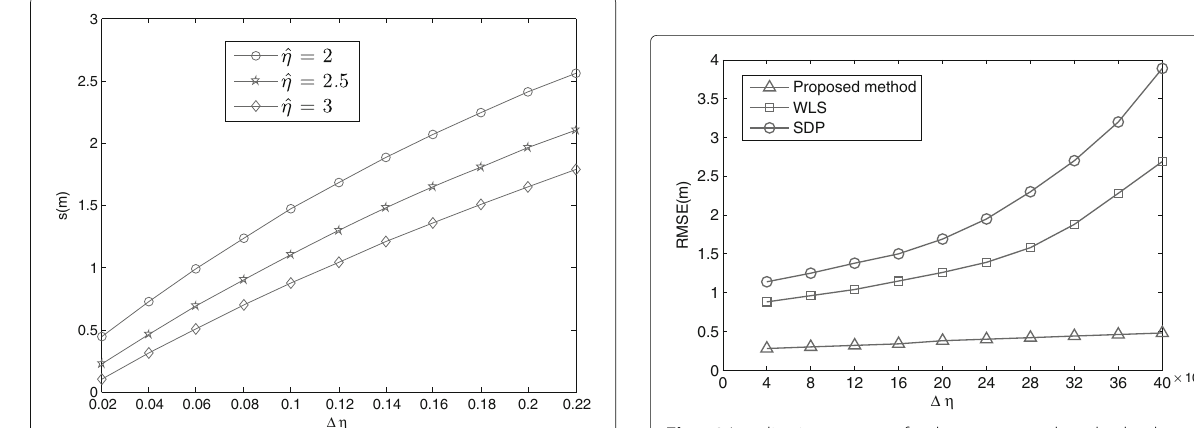
Fig. 9 Relationship of step size and localization error